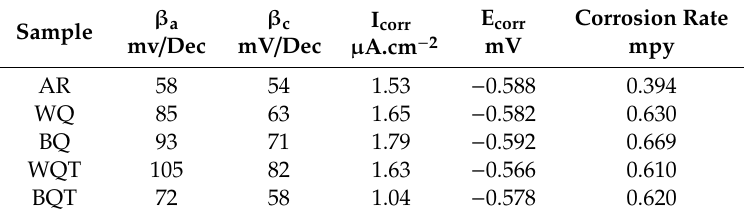
Table 4. Kinetic parameters of as-received and heat-treated low-carbon steel in 1 vol% HNO 3.